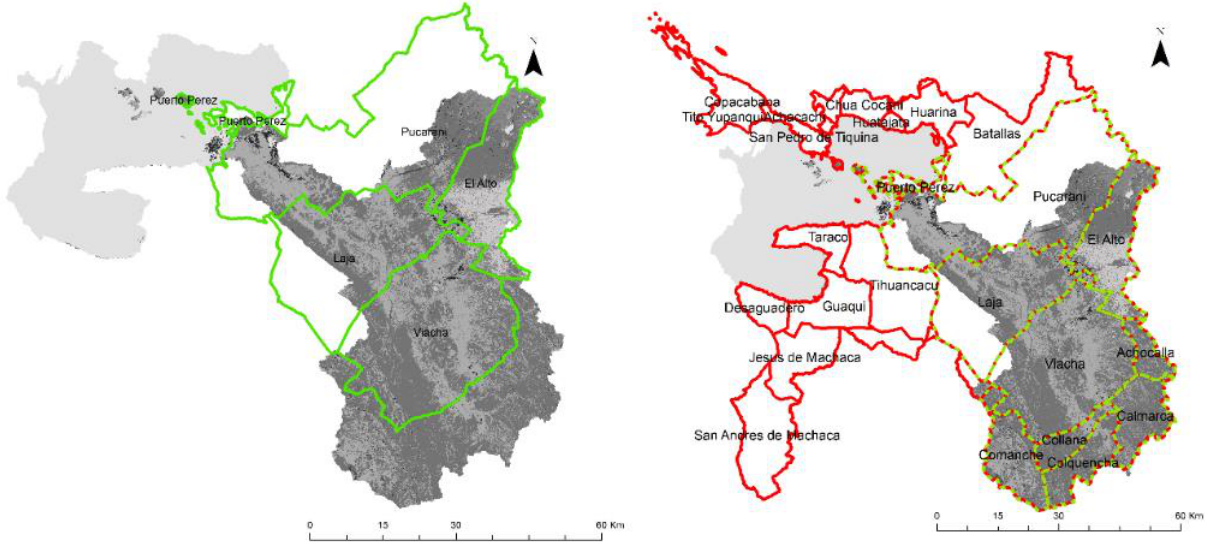
Figure 4. Spatial scale. Left shows the intersection between the KRB and the main jurisdictions involved. The right shows the 2018 KRB intersected with the 2018 Katari River Basin Plan jurisdictions involved.